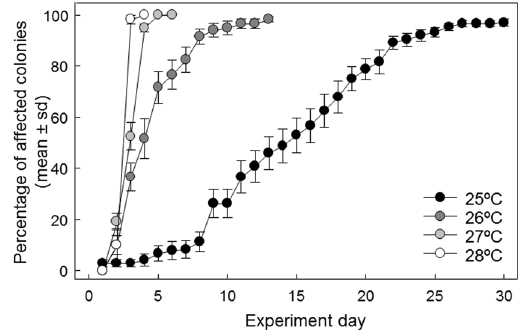
Figure 3. Results of the experiments to evaluate the thermotolerance thresholds of P. clavata . Daily mean ( ± SE) percentage of affected colonies (tissue necrosis > 0%) for each temperature treatment: 25 °C, 26 °C, 27 °C and 28 °C. The 25 °C results correspond with the results of the ladder experiment from the day when T reached 25 °C. For clarification purposes, the mean ( ± SE) values of all tested populations (pooling sites and depths) are presented for each